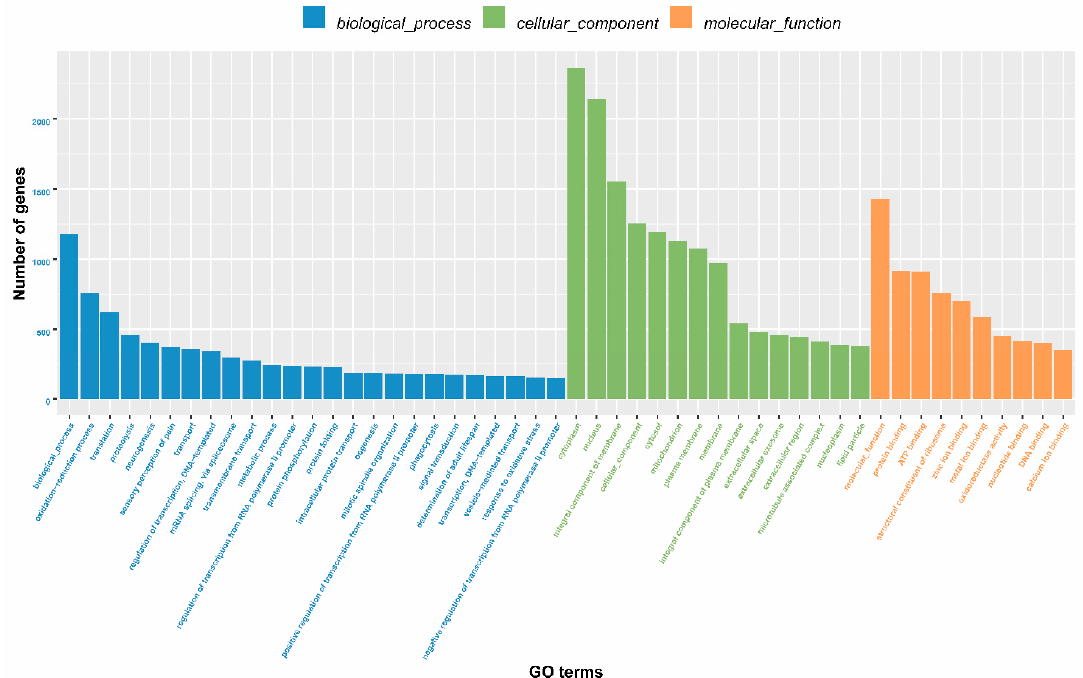
Figure 1. Gene ontology (GO) classification of Frankliniella occidentalis and Frankliniella intonsa unigenes.